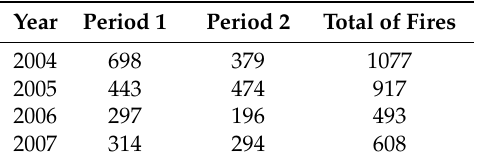
Table 2. Number of HCF locations by years and by seasonal